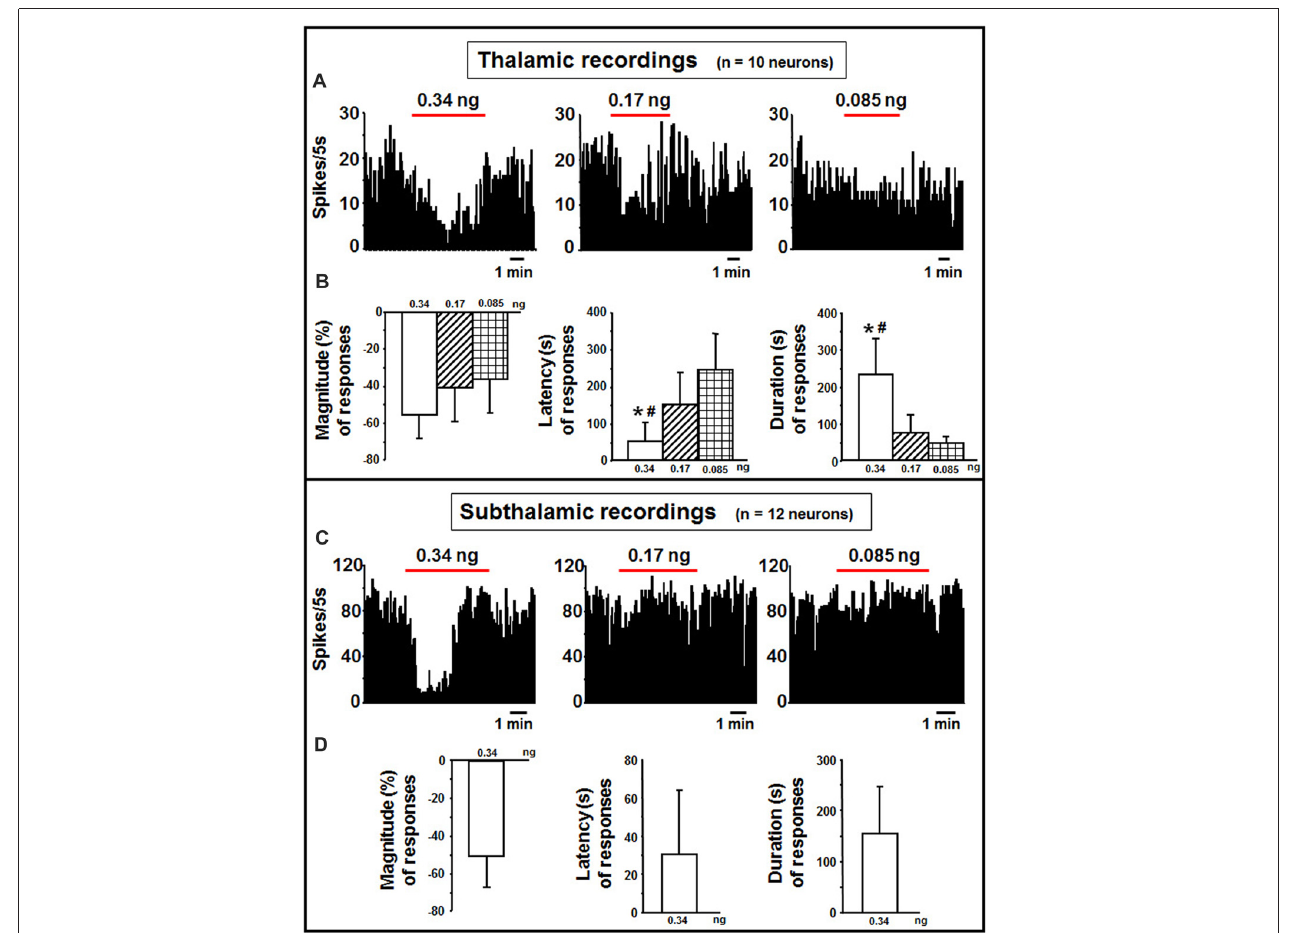
FIGURE 5 | Thalamic and subthalamic recordings. (A) Representative rate-meter histogram (bin width 5 s) showing the firing rate of a thalamic neuron following indicaxanthin administration at various amounts (0.34, 0.17, 0.085 ng/neuron) for 5 min. (B) Bar histogram for magnitude, latency and duration showing the significant effect of indicaxanthin at different amounts (0.34, 0.17, 0.085 ng/neuron) on thalamic neuronal responses ( n = 10). Each bar represents mean values ( ± standard deviation; ∗ statistically significant effect of indicaxanthin 0.34 vs. 0.17 ng/neuron; # statistically significant effect of indicaxanthin 0.34 vs. 0.085 ng/neuron). Statistical significance for P < 0.05. (C) Representative rate-meter histogram (bin width 5 s) showing the firing rate of a subthalamic neuron following indicaxanthin administration at various amounts (0.34, 0.17, 0.085 ng/neuron) for 5 min. (D) Bar histogram for magnitude, latency and duration showing the significant effect of indicaxanthin at 0.34 ng/neuron on subthalamic neuronal responses ( n = 12). Each bar represents mean values ( ± standard deviation). Statistical significance for P <